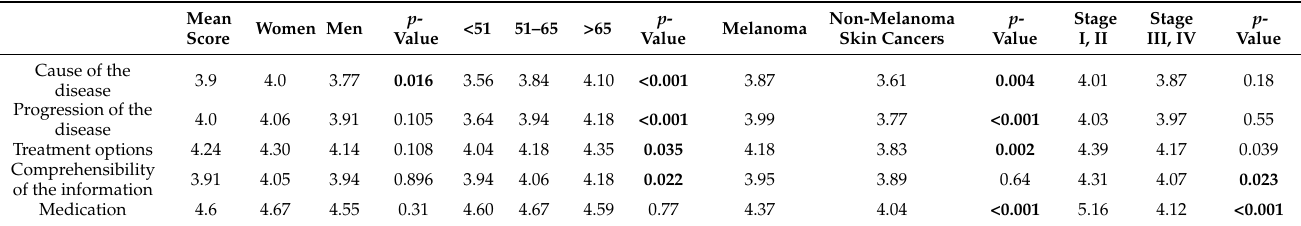
Table 3. Level of satisfaction with the provided